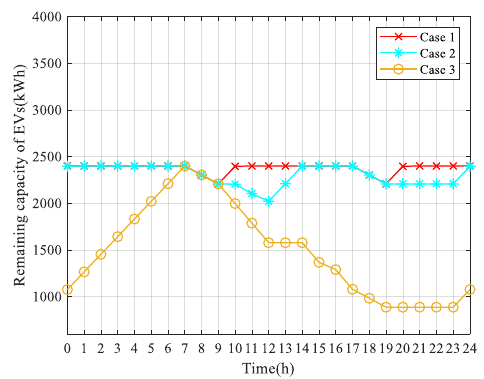
Figure 11. Remaining capacity of EVs in three